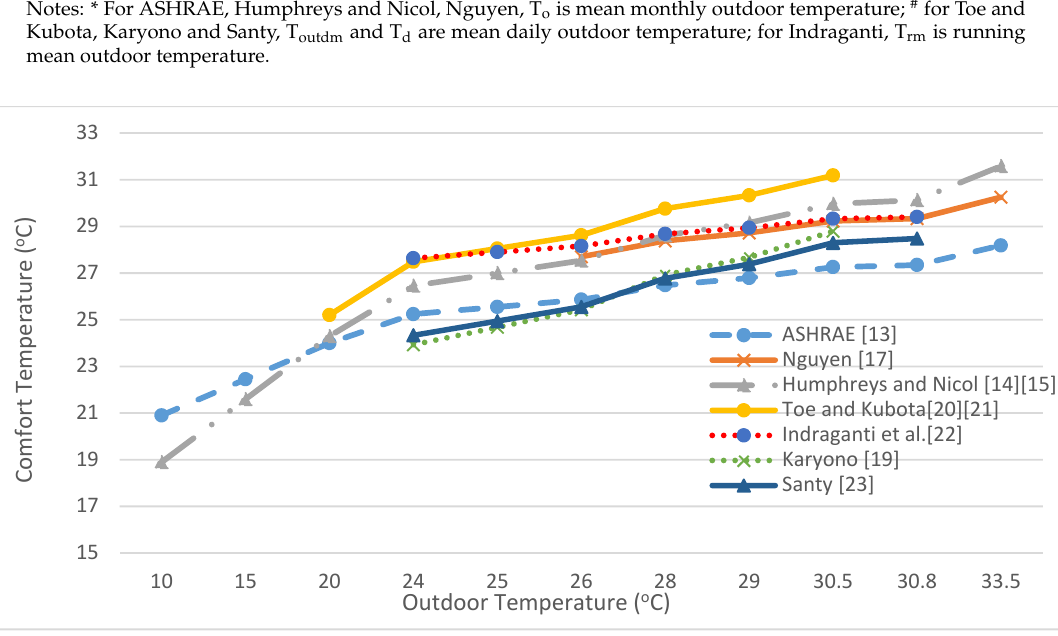
Figure 3. Comparison between adaptive comfort models in the literature.